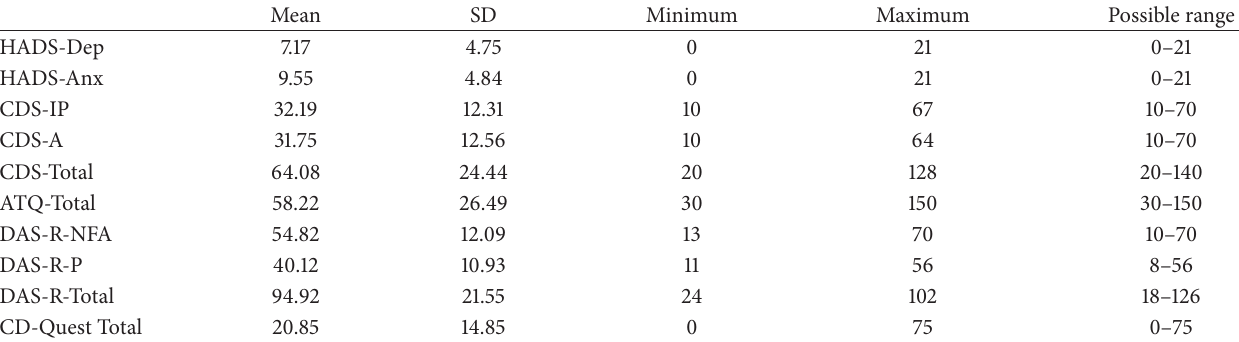
Table 1: Descriptive statistics of the total score of the CD-Quest, the remaining negatively biased cognition scales, and scales of mood severity. Mean SD